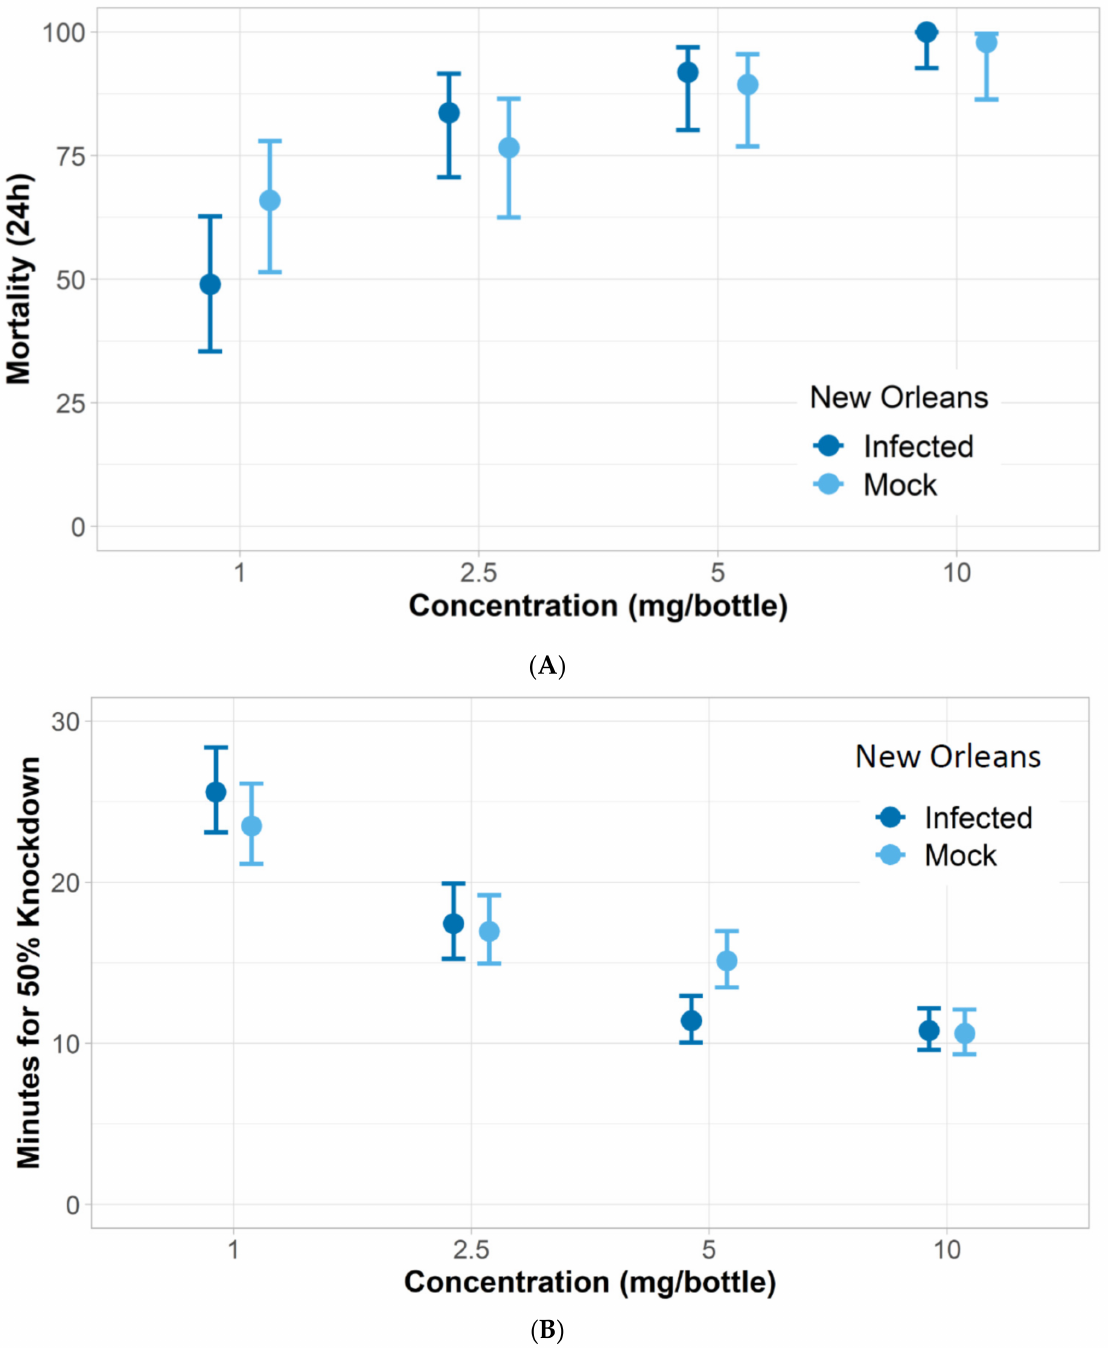
Figure 3. Response of New Orleans A. aegypti Zika-infected (infected) and uninfected (mock) mosquitoes when exposed to four concentrations of nootkatone (mg/bottle). ( A ) Mortality at 24 h and ( B ) 50% of knockdown time in